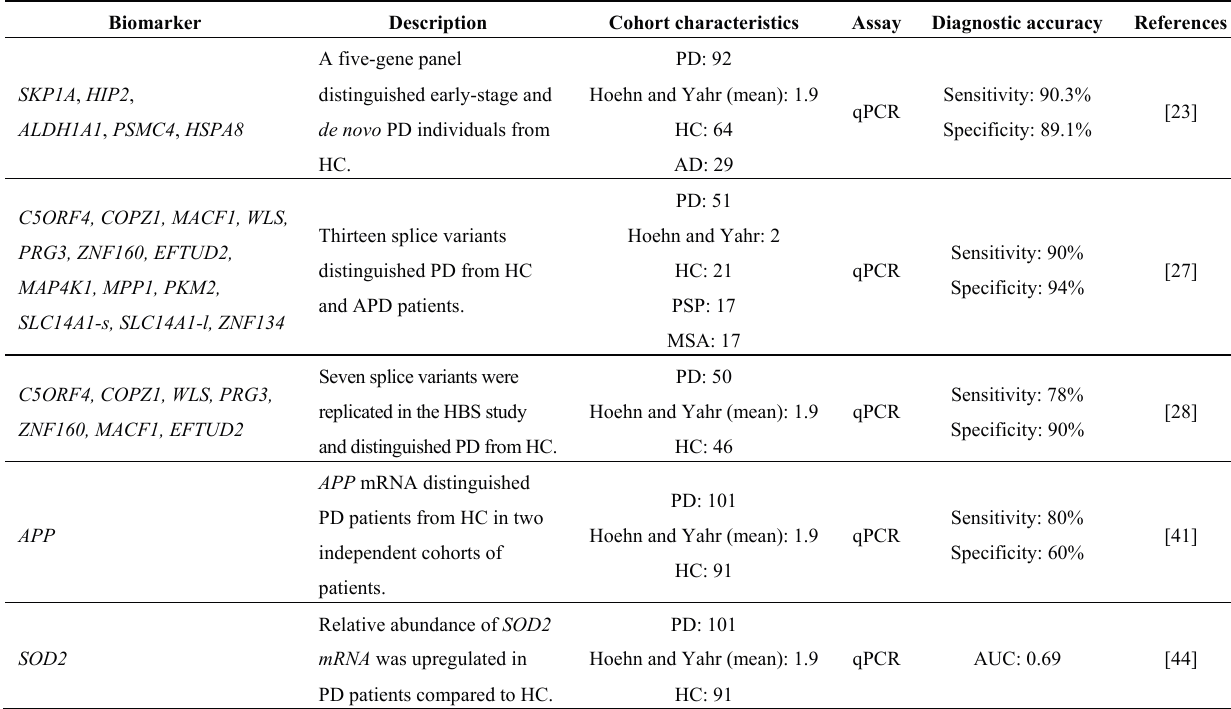
Table 2. Candidate RNA biomarkers in the blood of PD patients. The number of participants and the PD rating of the patients using the Hoehn and Yahr scale or the Unified Parkinson’s Disease Rating Scale (UPDRS) is provided under cohort characteristics. PD is Parkinson’s disease; HC is healthy control; AD is Alzheimer’s disease; MSA is multiple system atrophy; PSP is progressive supranuclear palsy; AUC is area under the